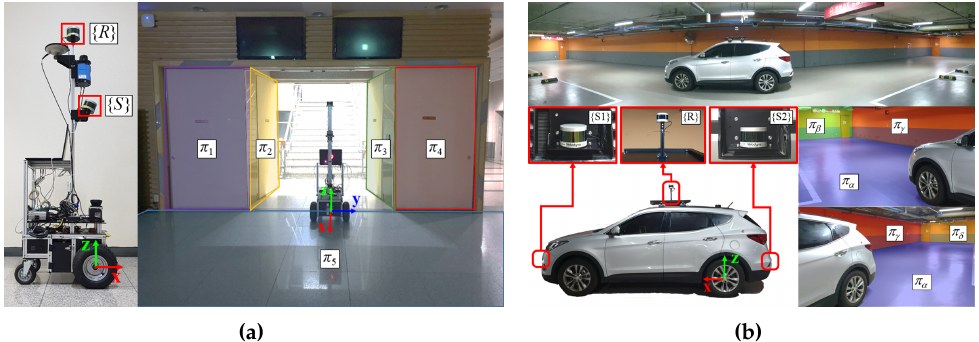
Figure 4. Experimental setup ( a ) a robotic system ( b ) a vehicular